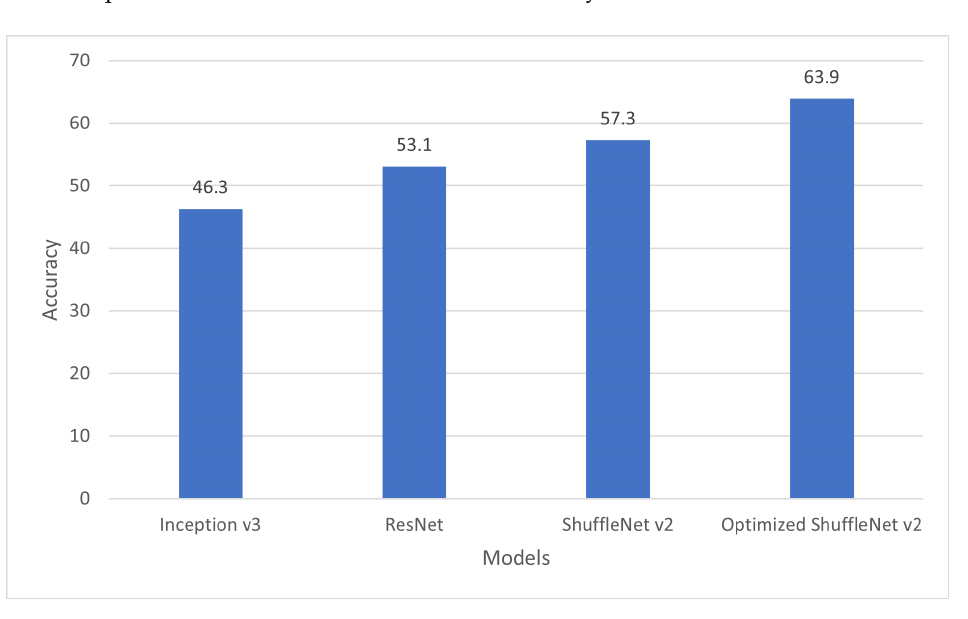
Figure 5. Classification accuracy of different